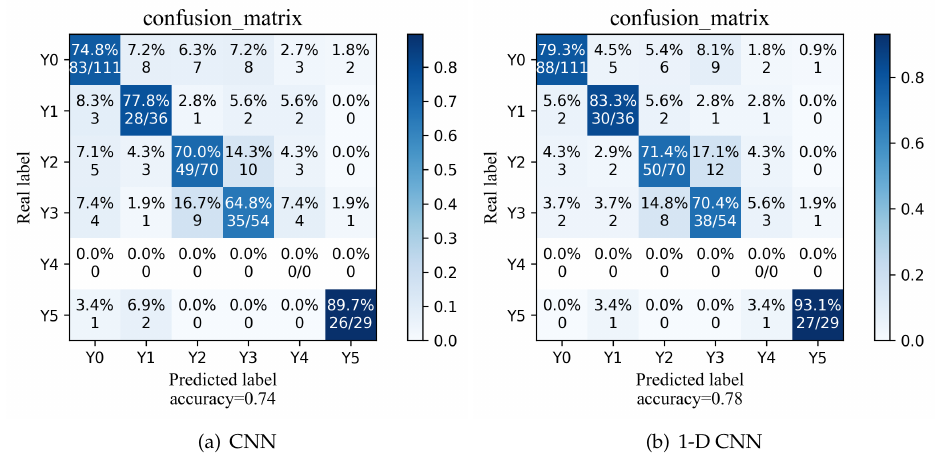
Figure 12. The confusion matrices of diagnosis